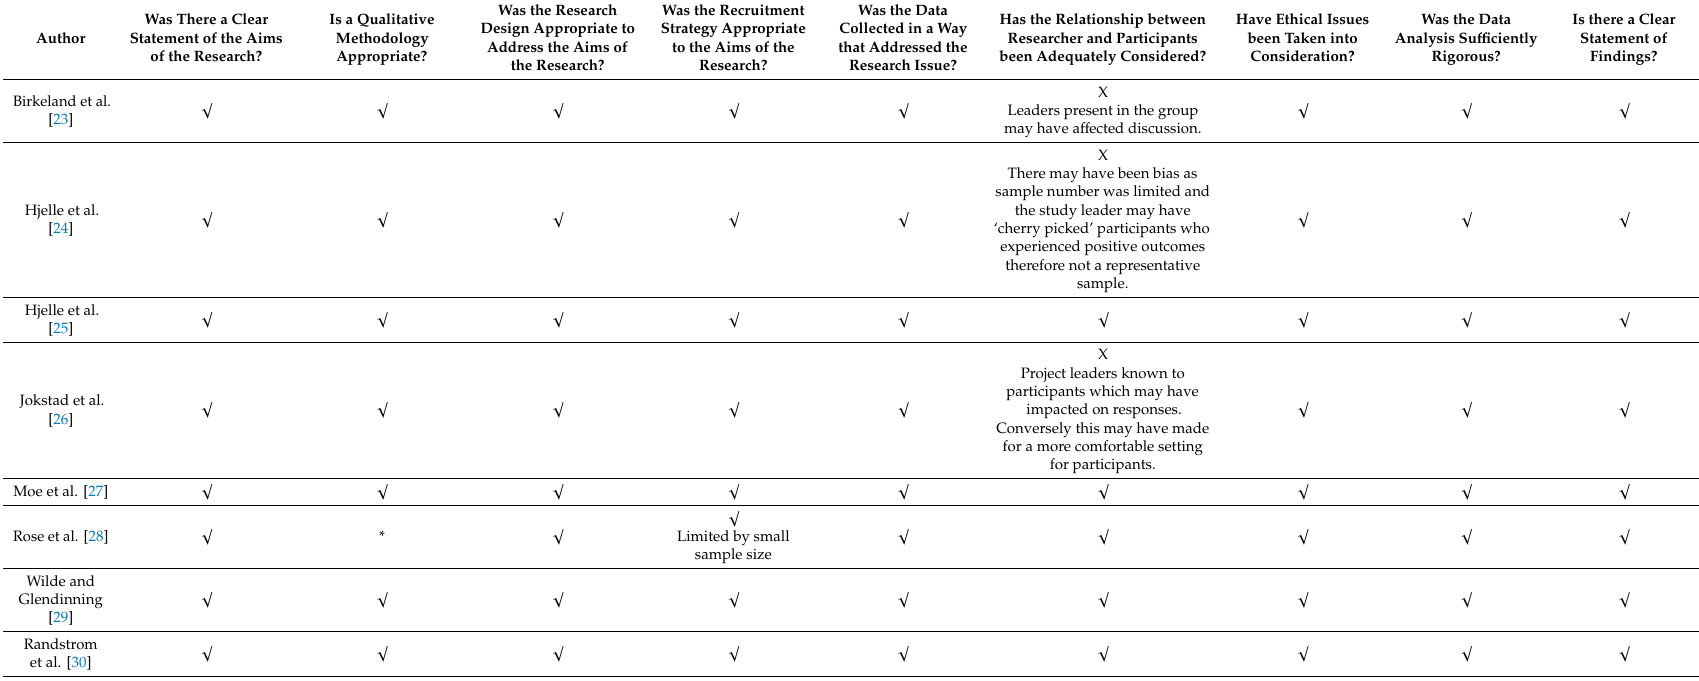
Table 1. Evaluation of Quality of Studies included using the Critical Appraisal Skills Programme